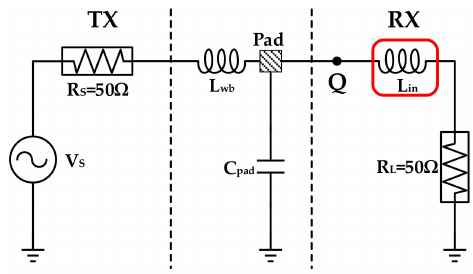
Figure 4. The proposed input matching circuit.